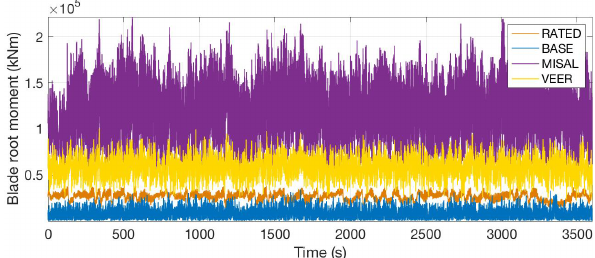
Figure 9. Time series of the resultant moment at the blade root for turbine simulations at a radial position of 12km with rated wind (RATED), baseline wind (BASE), wind with veer (VEER), and misaligned wind (MISAL).